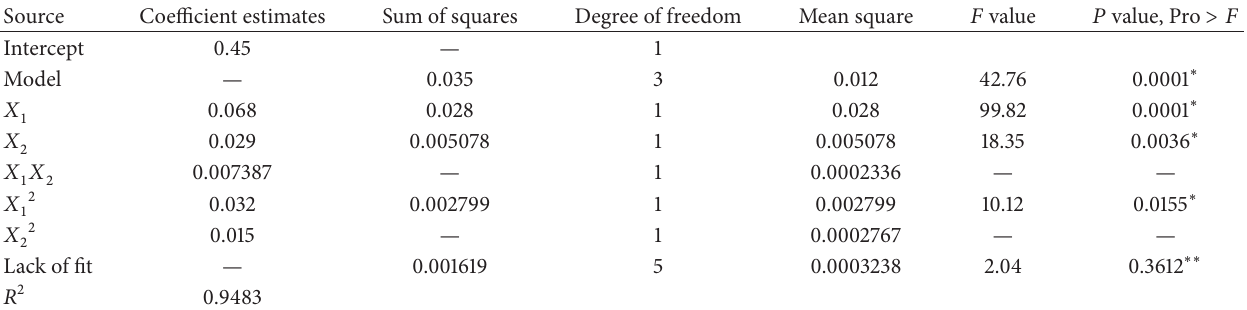
Table 8: Analysis of variance (ANOVA) for the effects of microwave power and microwave time on BI.